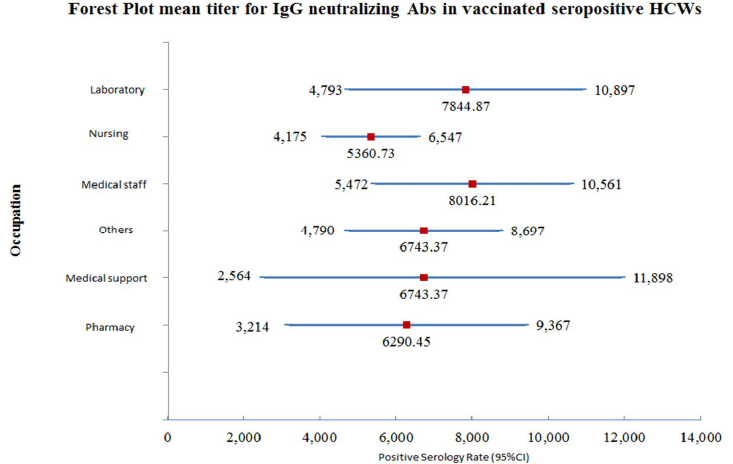
Figure 2. Forest plot for the mean titer and 95% CI for neutralizing antibody IgG antibody titer among vaccinated-seropositive HCWs.